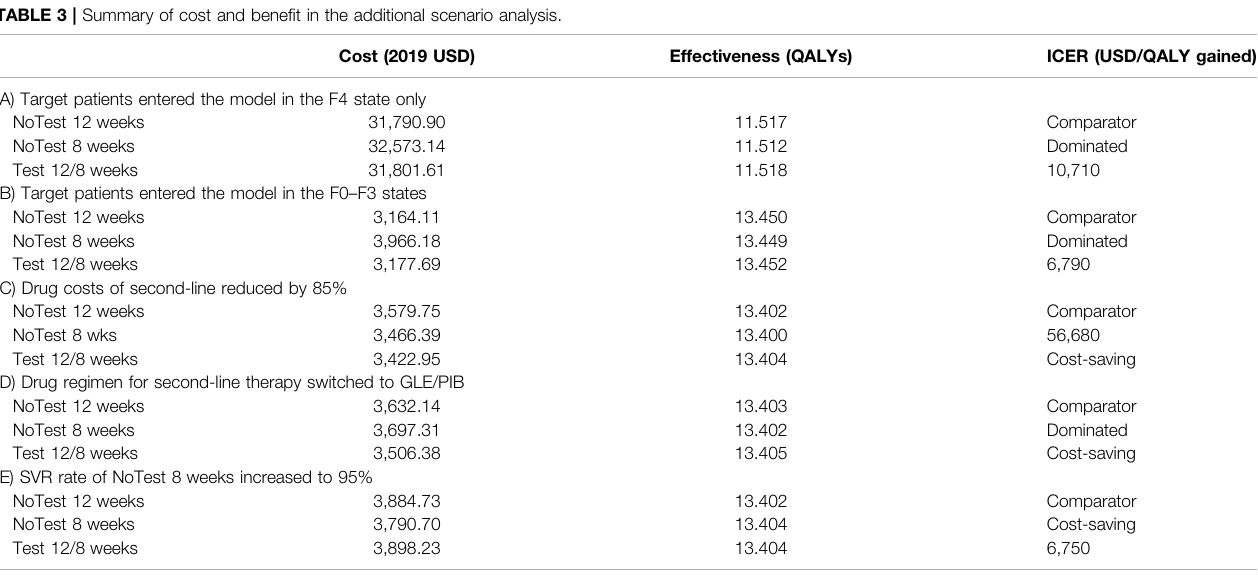
TABLE 3 | Summary of cost and bene fi t in the additional scenario analysis.